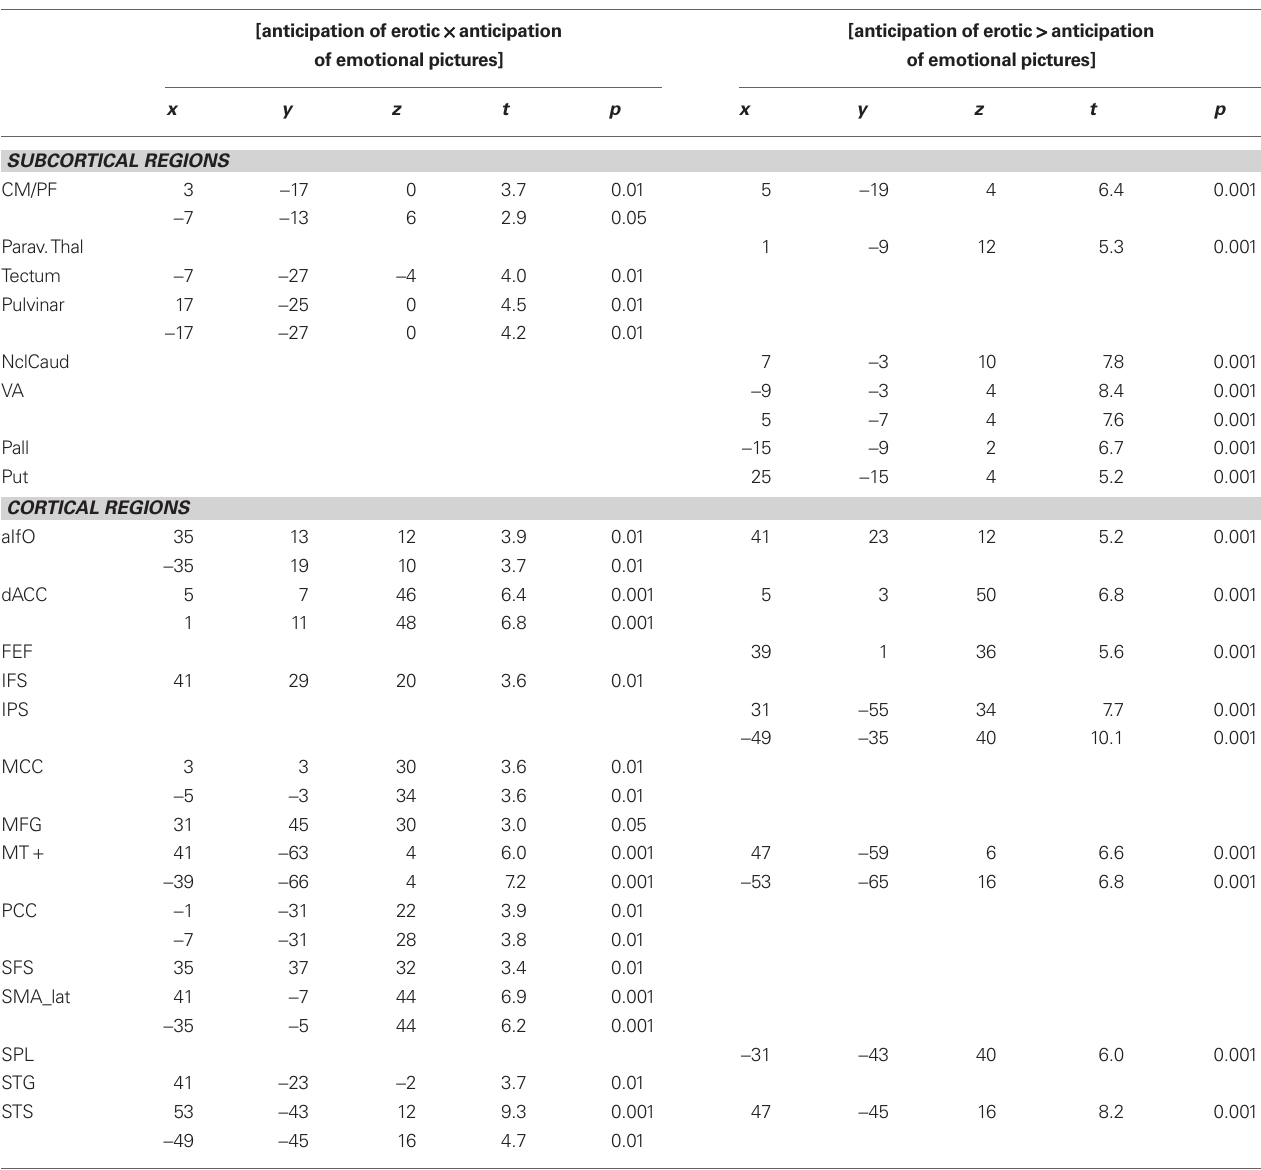
Table 2 | effects of